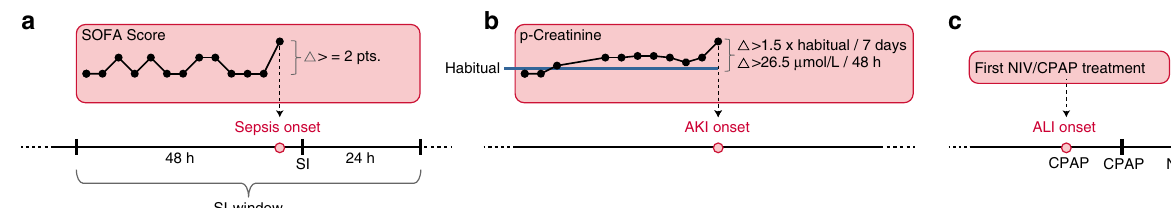
Fig. 5 Gold standards for sepsis, AKI, and ALI. Sepsis ( a ), AKI ( b ), ALI ( c ), suspected infection (SI).